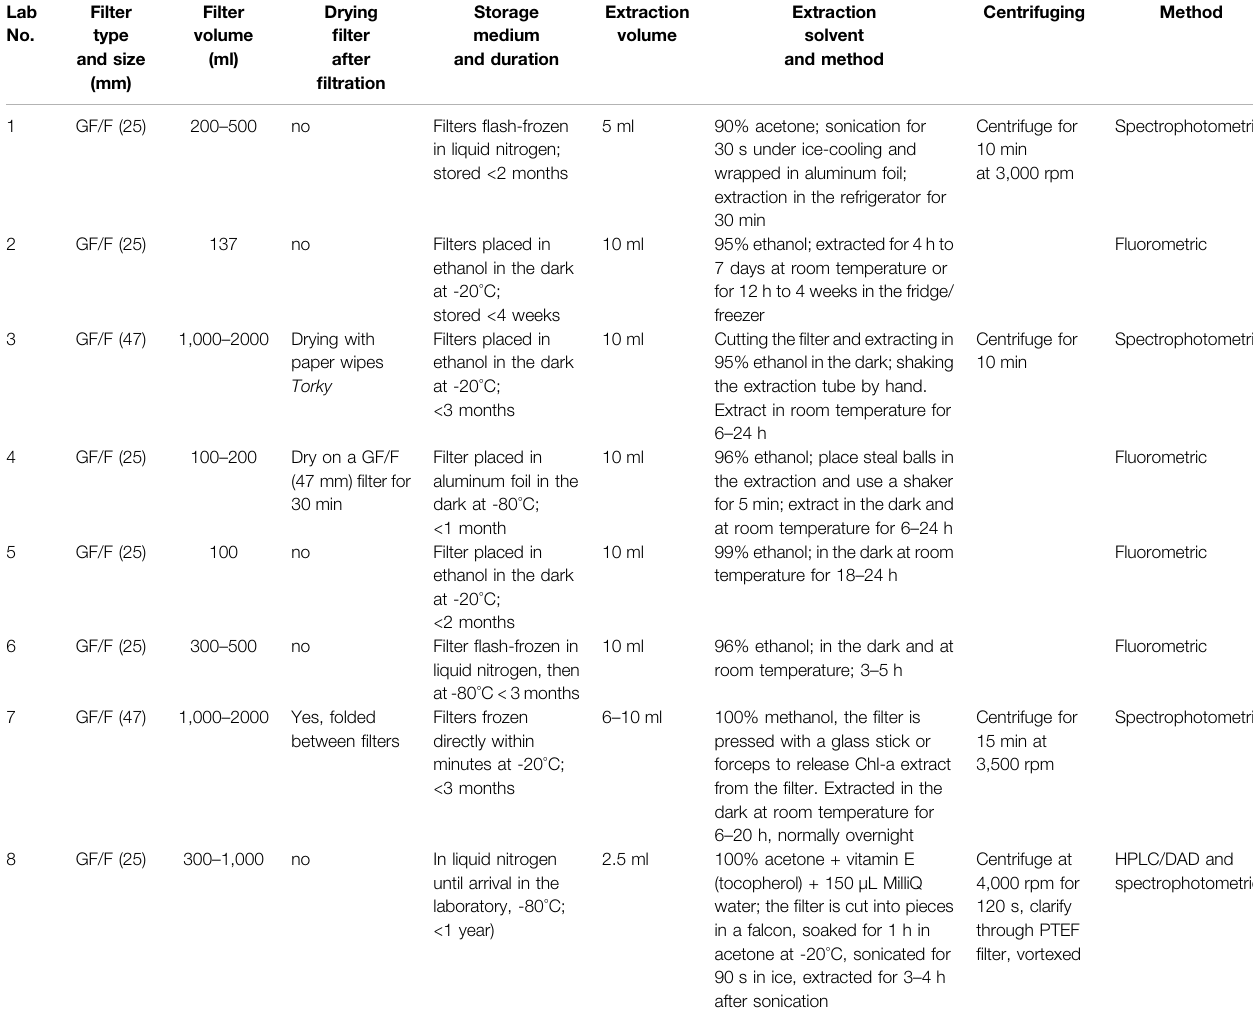
TABLE 1 | Key characteristics for chlorophyll-a measurements for the participating laboratories, Swedish monitoring laboratories: Labs 2 – 5. Lab